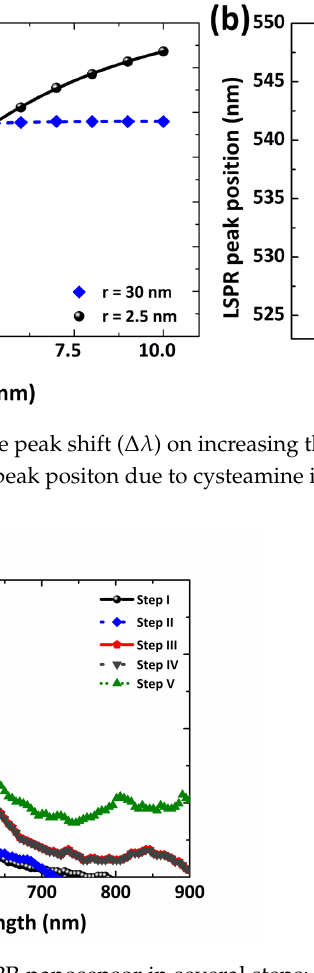
Figure 9. The label-free LSPR nanosensor in several steps: step I (Au NP colloid), step II (Au NP– cysteamine), step III (Au NP–cysteamine–IgG), step IV (Au NP–cysteamine–IgG–glycine) and step V (Au NP–cysteamine–IgG–glycine–dengue NS1 antigen). Table 2. Recently reported η RIS and dengue identification via label-free LSPR platform using Au